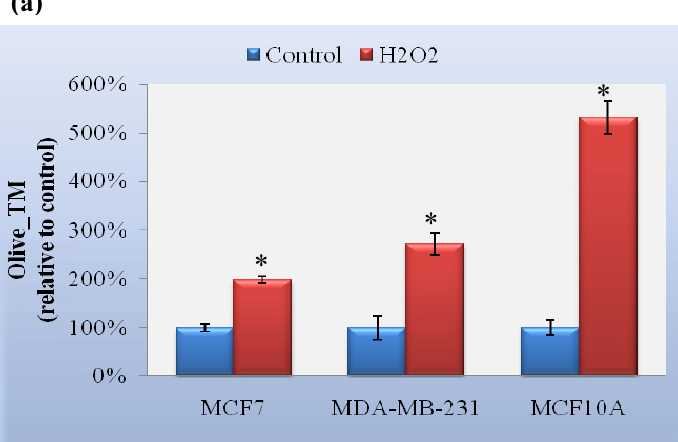
Figure 4. Olive Tail Moment (Olive_TM) as the mean ± SEM for three independent O injury; ( b ) after 24 h of HT or TY treatment, and ( c ) after 24 h of assays. ( a ) After an H 2 2 HT or TY treatment followed by an H O 2 2